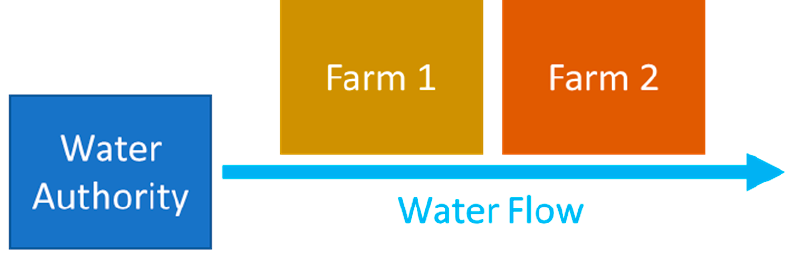
Figure 1. Schematic representation of the simplified irrigation district.